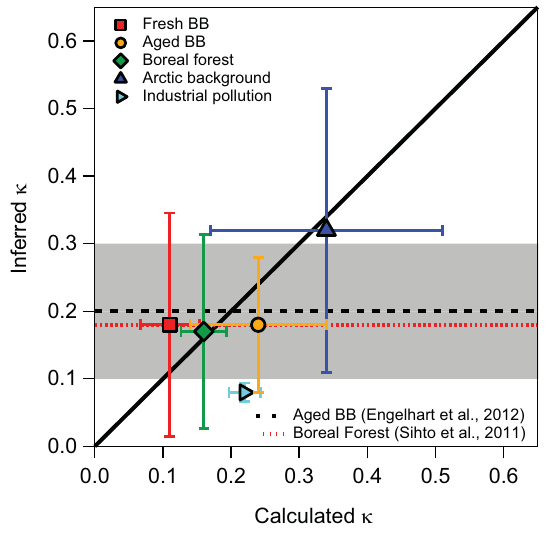
Fig. 5. κ inferred from CCN measurements vs. κ calculated from HR-ToF-AMS and PILS-WSOC chemical composition for each source type assuming that composition is size-independent and in- ternally mixed. Error bars denote one standard deviation from the mean. Dashed lines indicate reported literature κ values for aged biomass burning (BB) (Engelhart et al., 2012) and boreal forest aerosol (Sihto et al., 2011). Shaded area indicates the standard de- viation in the reported literature values of κ